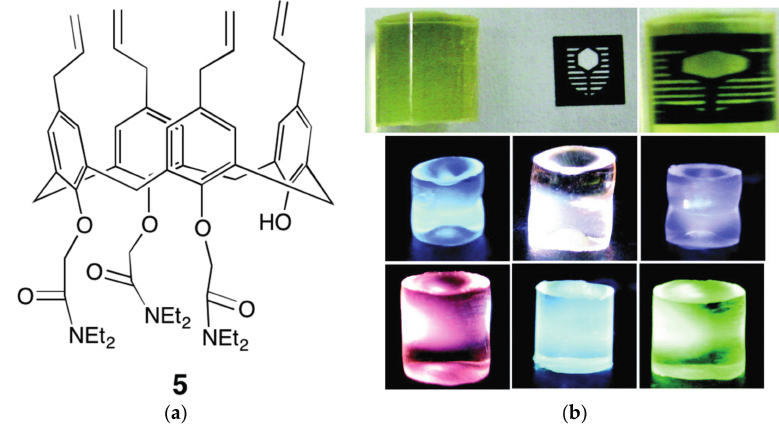
Figure 6. ( a ) The trisamide substituted p -allylcalix[4]arene 5 ; ( b ) examples of the polymer monoliths showing the transparency of the matric ( top ), and the variation of emitted colours obtained by loading single lanthanoid salts or mixtures. Reproduced by permission of The Royal Society of Chemistry from